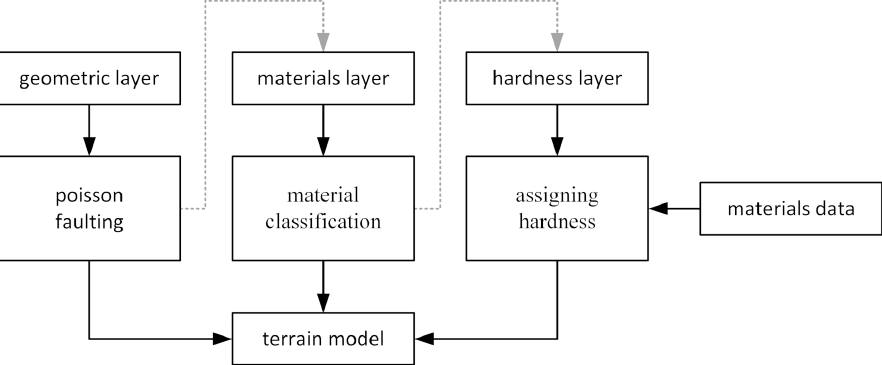
Figure 3. General schema of the proposed terrain